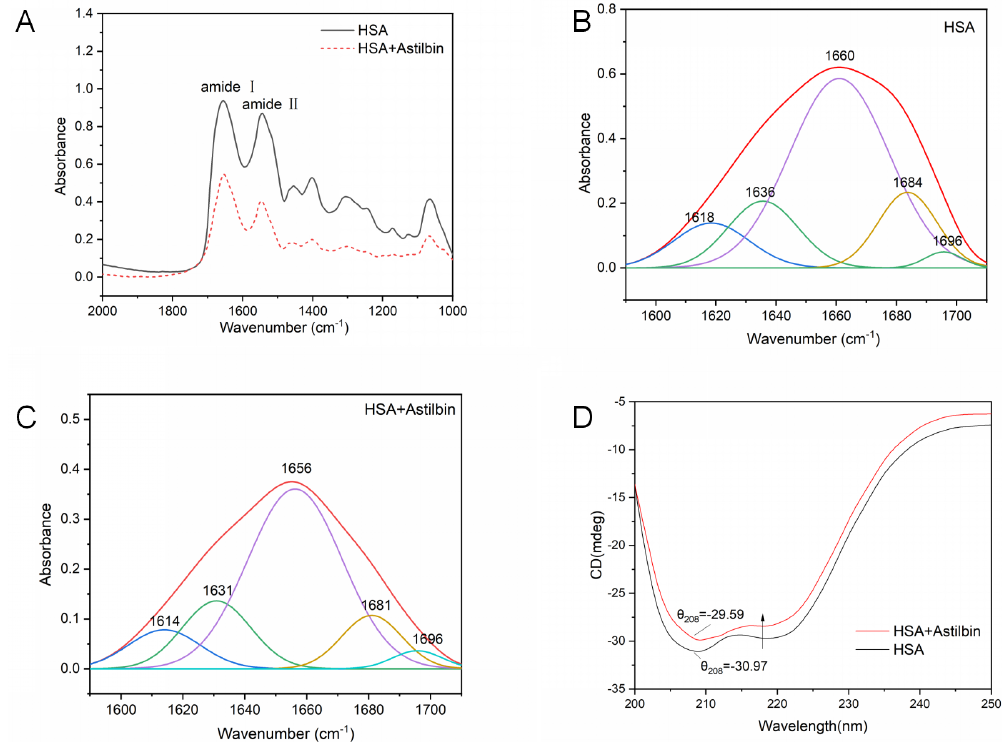
Figure 6. ( A ) Micro-FTIR spectra of HSA and HSA − astilbin system. ( B ) Curve fitting micro-FTIR spectra of infrared amide I band of HSA. ( C ) Curve fitting micro-FTIR spectra of infrared amide I band of HSA − astilbin system. ( D ) CD spectra of HSA and HSA − astilbin system.